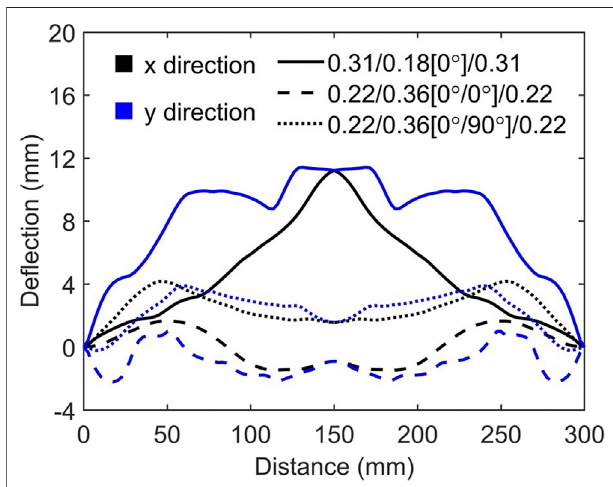
FIGURE 6 | The fi nal deformation pro fi les of FML plates under the impulsive load of Z (cid:2) 1 . 82 m / kg 1 / 3 .